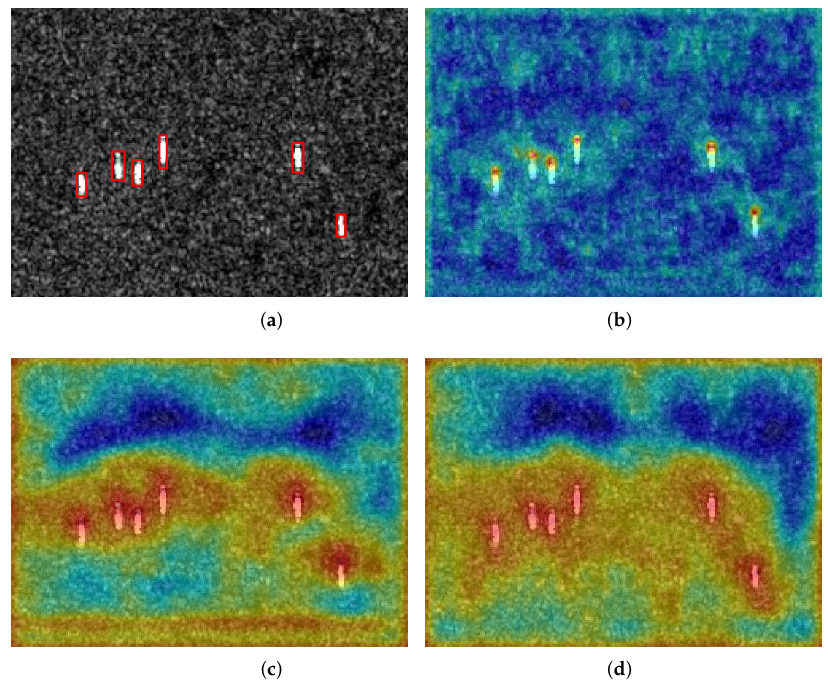
Figure 15. Visualization of the confidence maps. ( a ) Ground truth. ( b ) Visualization of the baseline. ( c )Visualization without non-local in WCFF. ( d ) Visualization with non-local in